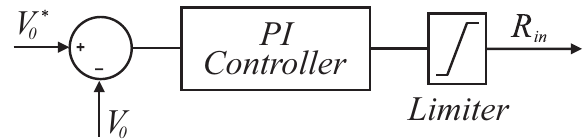
Figure 5. R in controller and its maximum R in